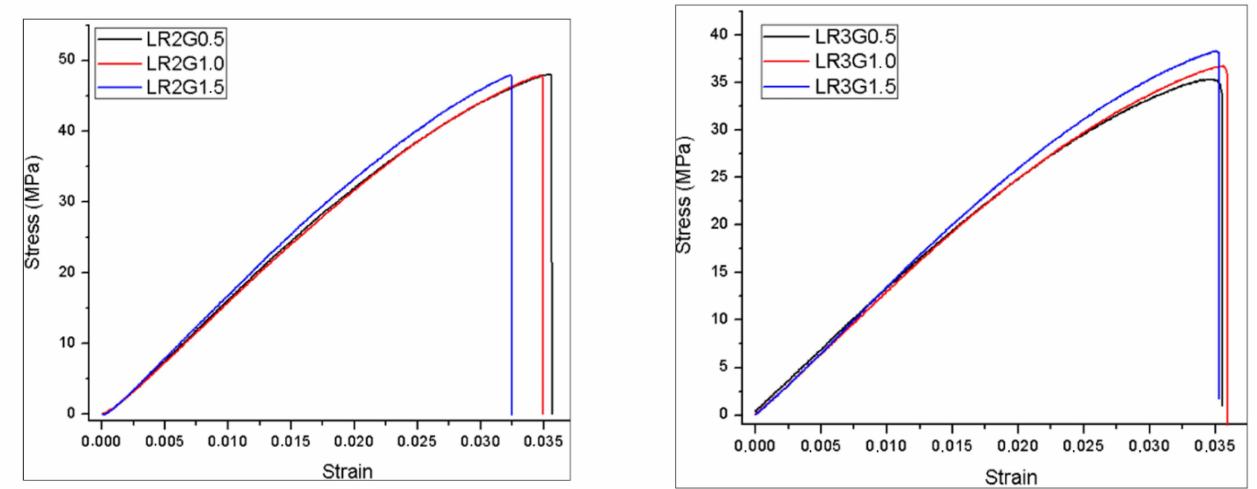
Figure 6. Stress-strain curves of the recycled rubber composites reinforced with GnPs (LRG)